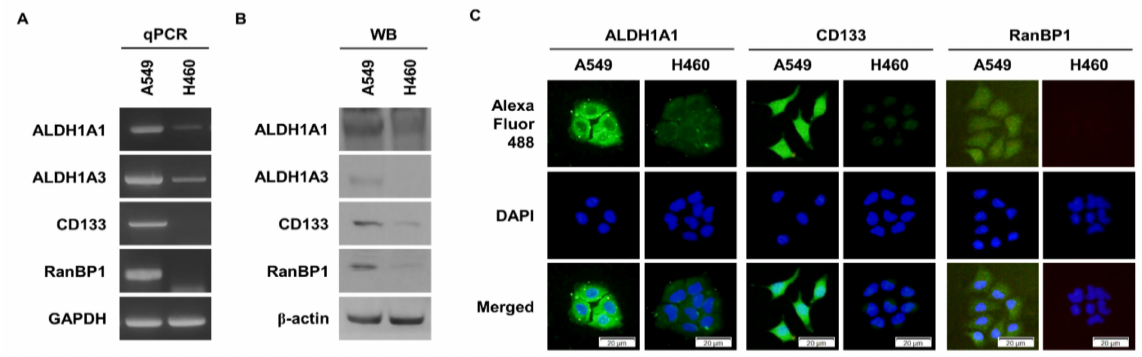
Figure 1. High expression of RanBP1 in A549 cells. ( A ) Comparison of the gene expression of CSC markers in A549 and H460 cells. GAPDH is used as a loading control. ( B ) Comparison of the expression of CSC marker proteins in A549 cells and H460 cells. β -actin is used as a loading control. WB: Western blotting. ( C ) Comparison of CSC marker protein expression through an ICC